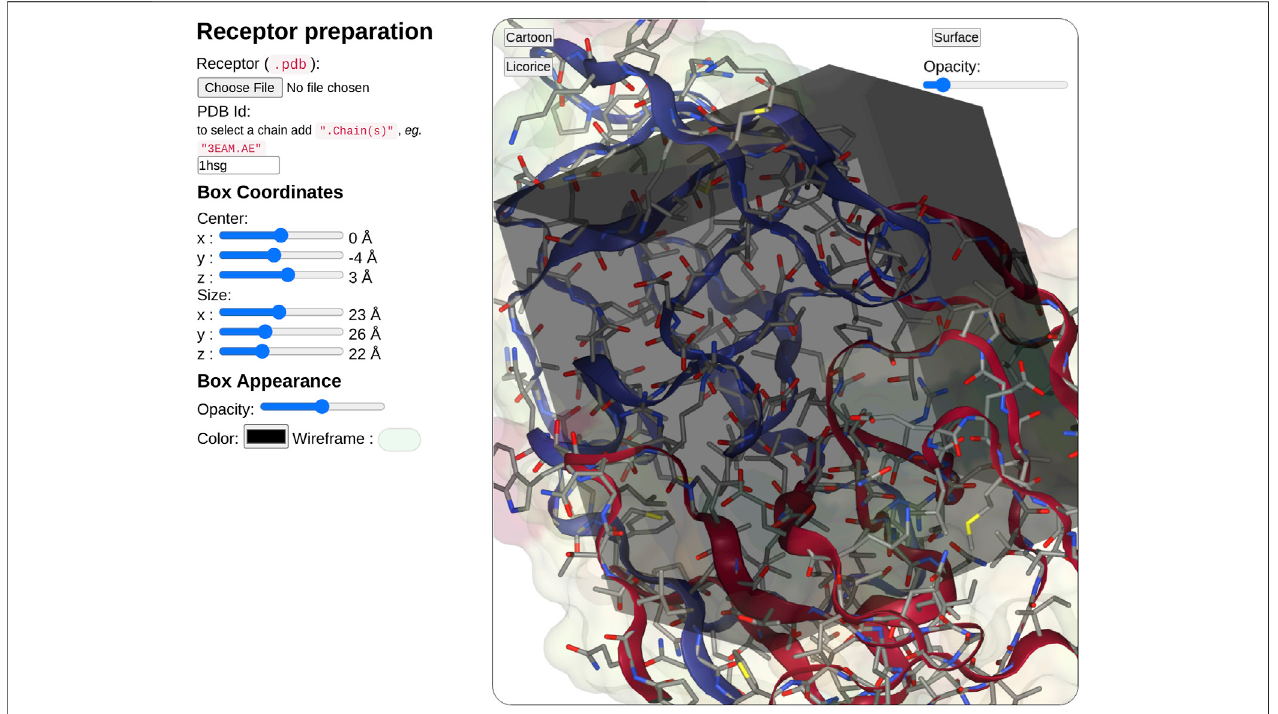
FIGURE3| Overview ofthereceptor inputinterface. SeamDockprovidestwo options forreceptor input.Users canprovideareceptor structure fi le oftype pdb, or enter a PDB ID, with or without a selection of chains. After receptor preparation completion, its 3D structure will be displayed in a NGL stage. The NGL stage will also show the docking box, in which the position and size can be adjusted interactively through the six sliders on the left side. Box and receptor appearance can be personalized by the user.